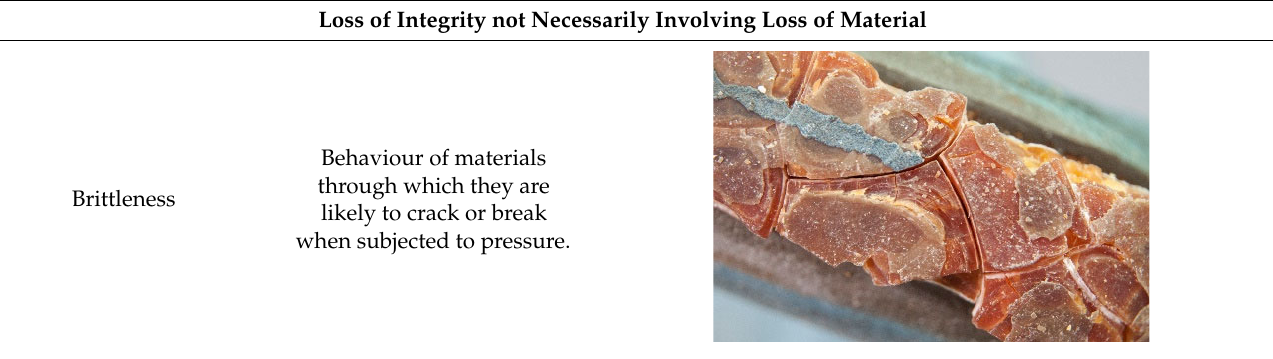
Table 6. Definitions of the subcategory ‘loss of integrity not necessarily involving loss of material’. Loss of Integrity not Necessarily Involving Loss of